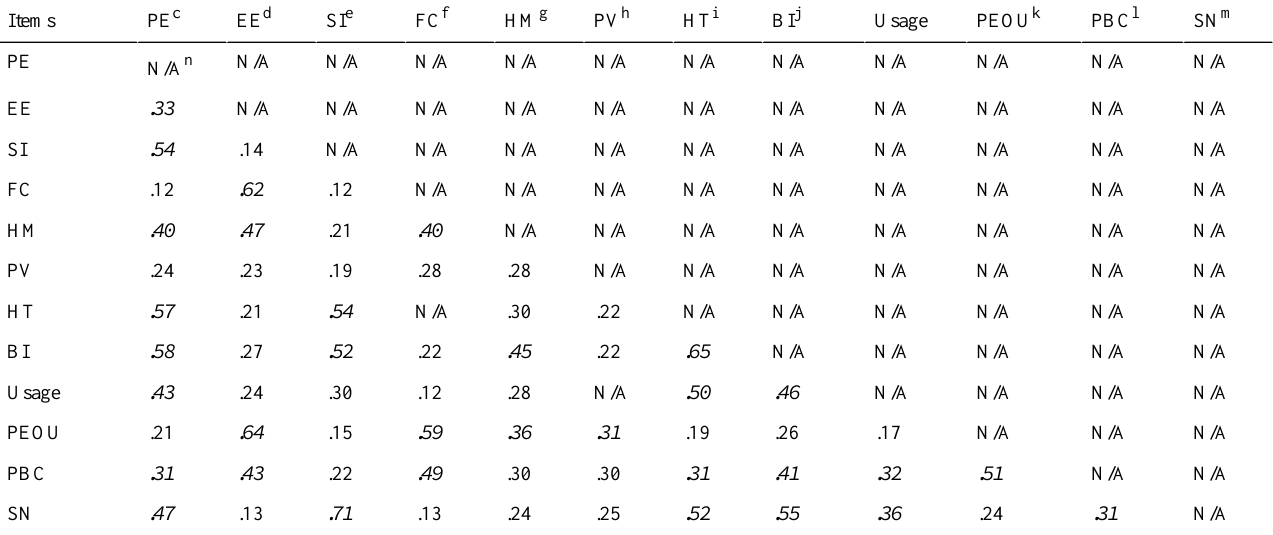
Table 5. Matrix of Pearson correlations in sample 4 (n=319) a,b